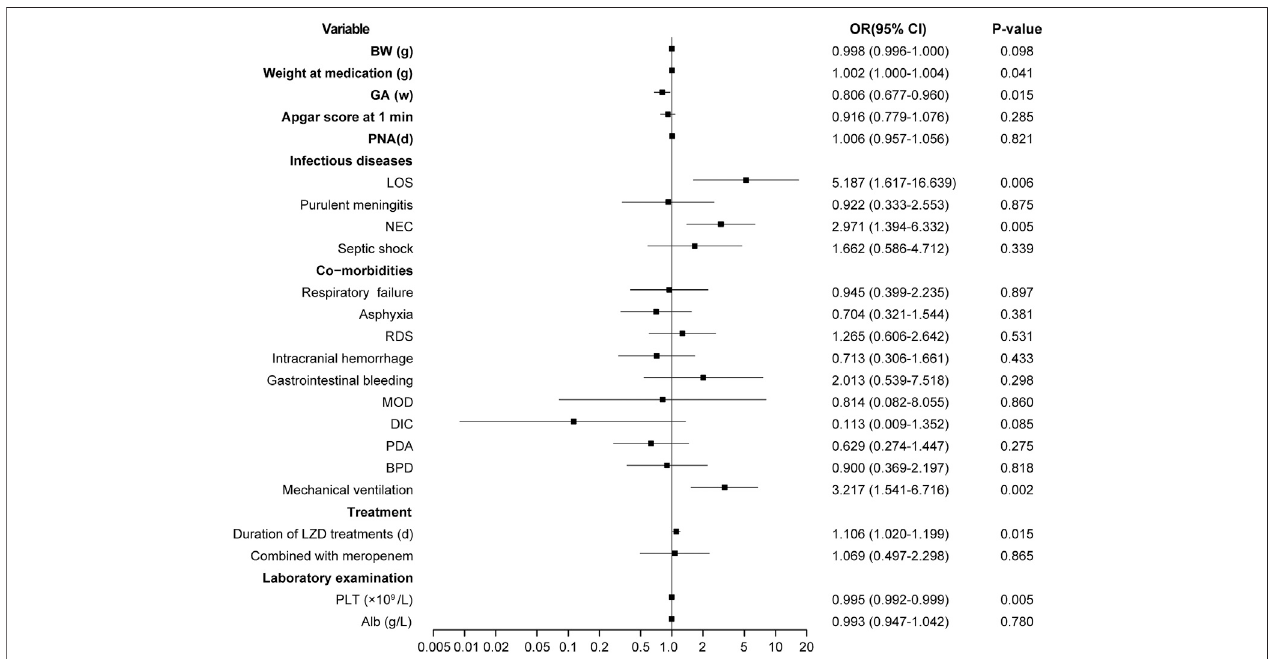
FIGURE 4 | Results of thrombocytopenia risk factors screened by multifactor logistic regression analysis. OR, odds ratio; BW, birth weight; GA, gestational age; PNA,postnatalage;LOS,late-onsetsepsis;NEC,neonatalnecrotizingenterocolitis;RDS,respiratorydistresssyndrome;MOD,multi-organdamage;DIC,disseminated intravascular coagulation; PDA, patent ductus arteriosus; BPD, bronchopulmonary dysplasia; LZD, linezolid; PLT, platelet; Alb, albumin.